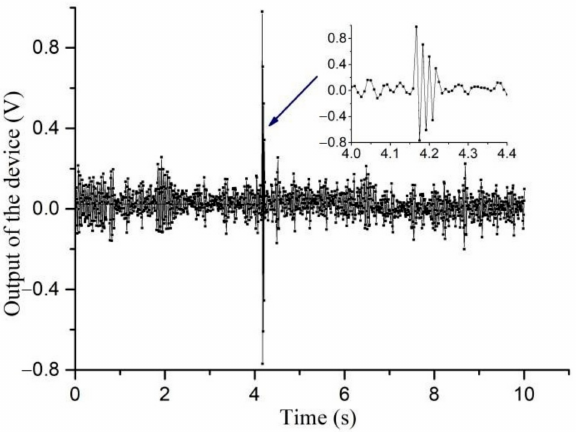
Figure 8. Tilt vibration isolation output of the device under close-loop